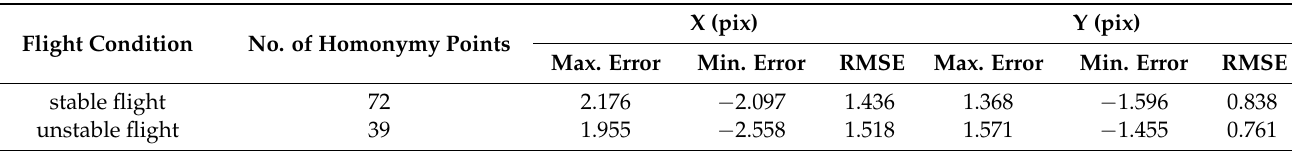
Table 19. Stitching error of EA-unstable-5 (left-middle image).